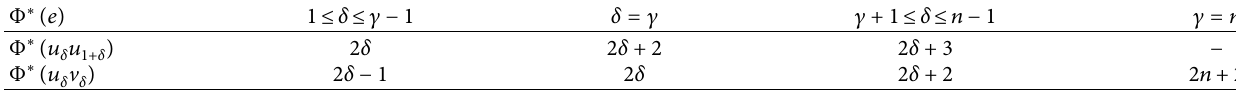
Table 28: Edge labeling of Φ ∗ ( e ) .